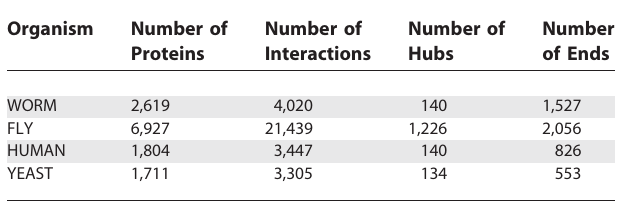
Table 1. Properties of Protein Interaction Datasets from